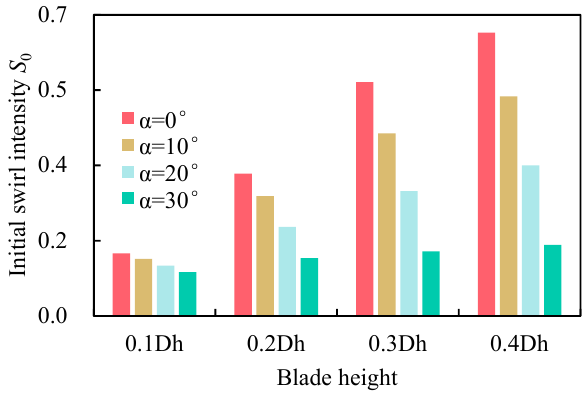
Figure 6. Effect of blade height and blade angle on initial swirl intensity.